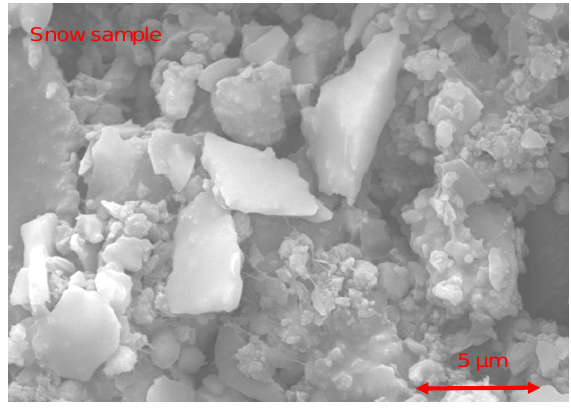
Fig. 6. SEM image of volcanic aerosol collected in a snow sample at the Jungfraujoch after the initial arrival of the volcanic aerosol plume (23 April